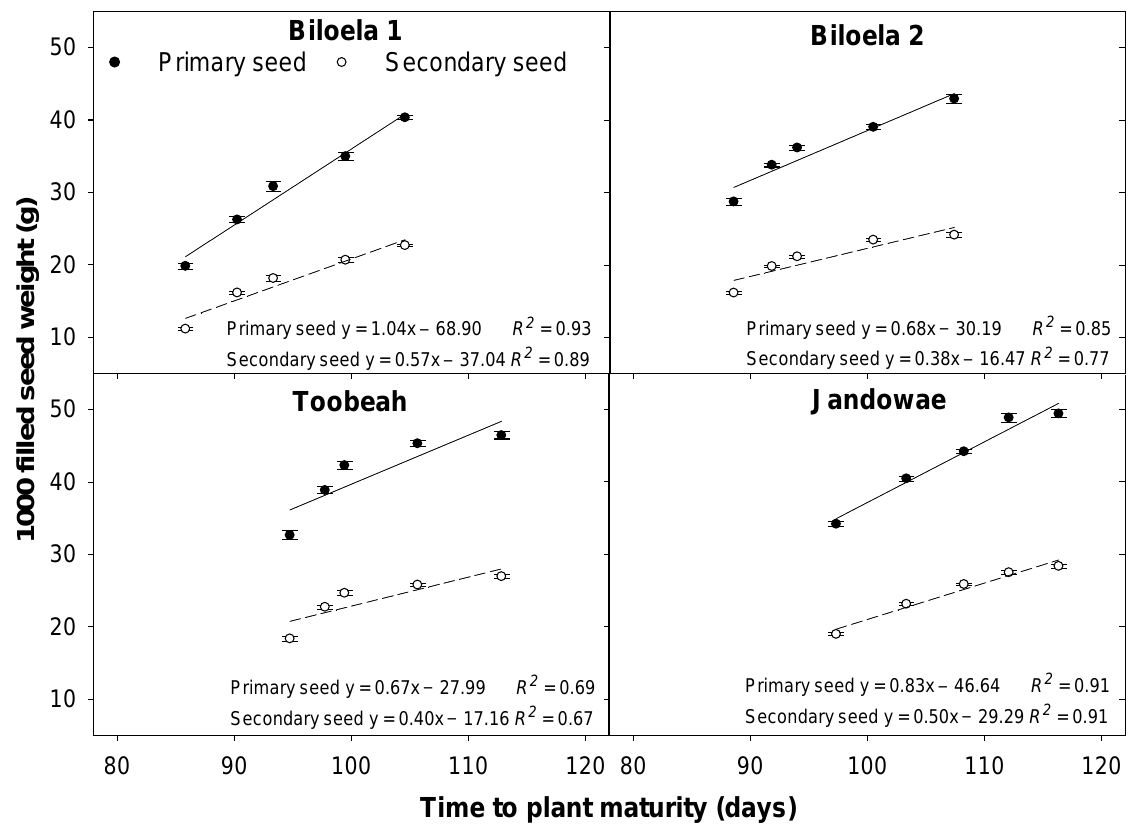
Figure 5. Relationship between the time to plant maturity and 1000 filled seed weight of both primary (solid symbol) and secondary (open symbol) seeds of four Avena sterilis ssp. ludoviciana biotypes. Error bars represent standard errors of the mean of 12 replicates and represent pooled data from two experimental runs. Lines represent fitted linear regressions.